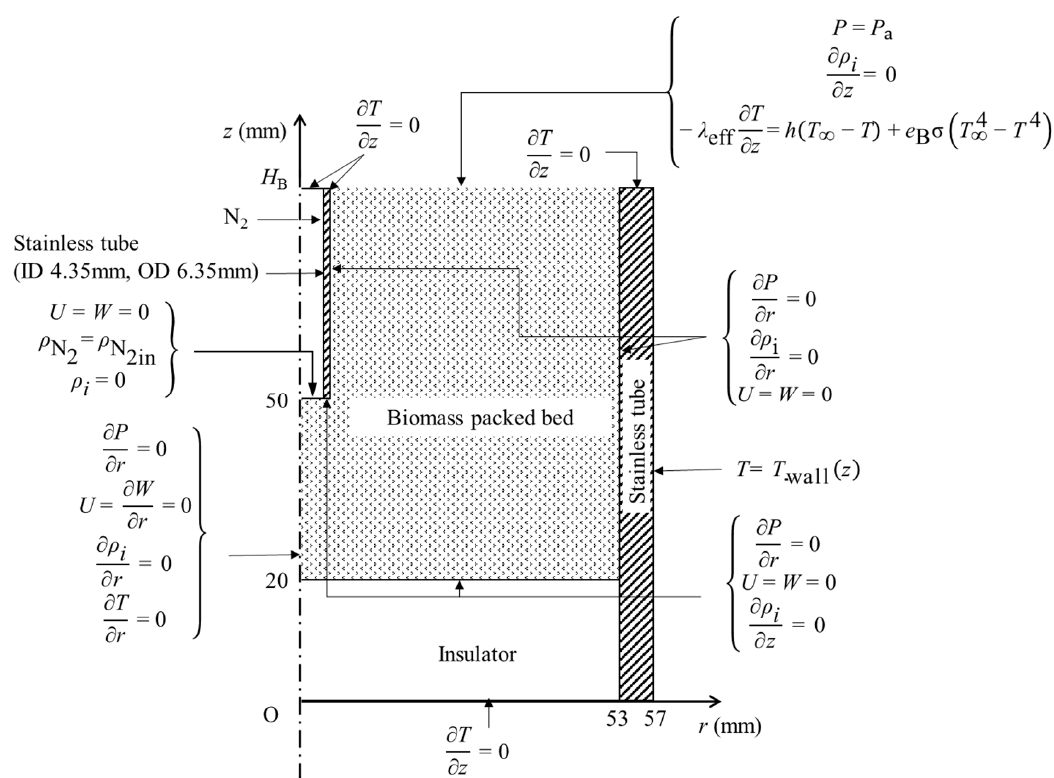
Figure 4. Boundary conditions of the numerical simulation during the biomass torefaction.